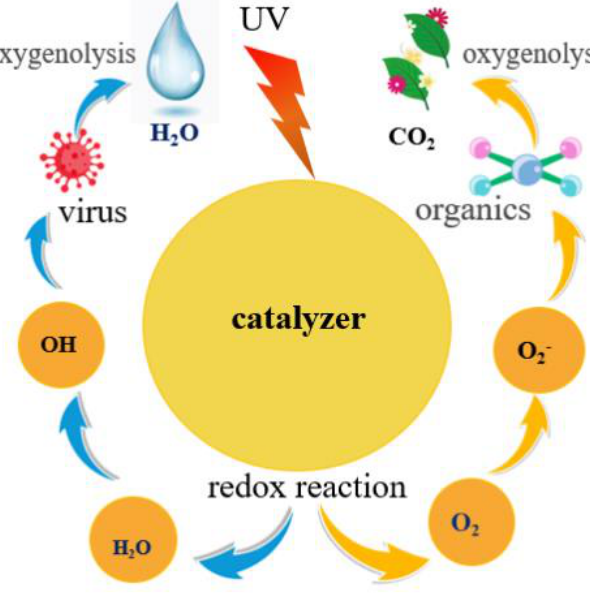
Figure 7. Photocatalytic mechanism diagram .